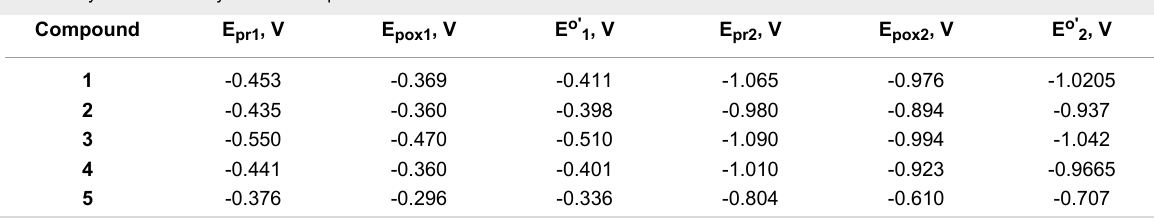
Table 1: Cyclic Voltammetry data for compounds 1 – 5 Compound